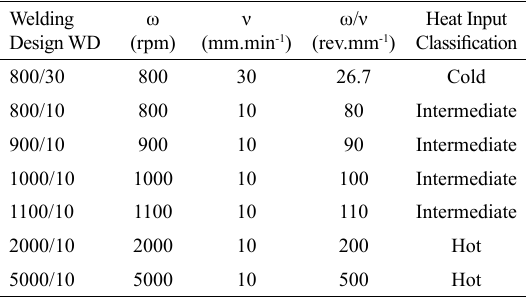
Fig. 2d corresponds to WD 1000/10 (Intermediate Welding), where no apparent flaws were